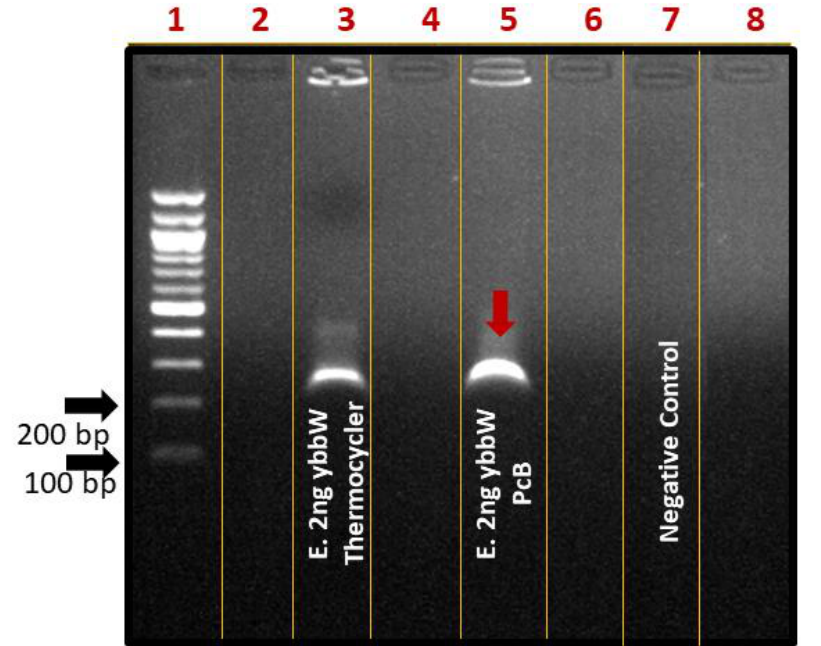
Figure 6. Agarose gel (2%) electrophoresis image of RPA reactions using ybbW primers and gDNA of E. coli TOP10 (2 ng) as a template. Lane 1: DNA ladder, Lane 3: positive control-ybbW amplified RPA product, RPA reaction on thermocycler, Lane 4: ybbW amplified RPA product, reaction on PCB chip, Lane 7: negative control-no gDNA, reaction on thermocycler.